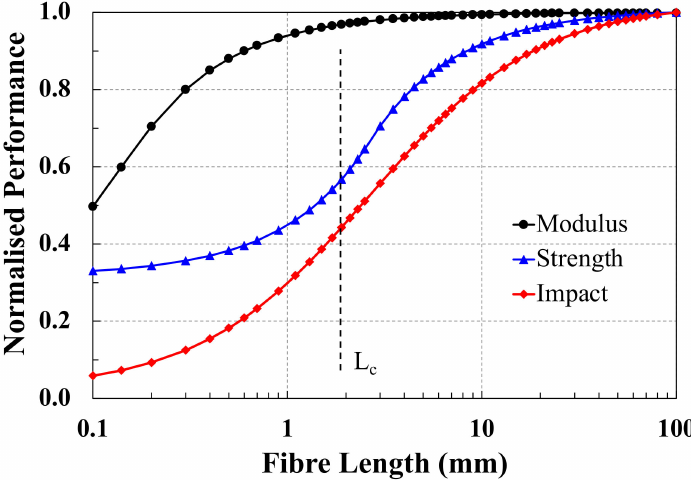
Figure 3. Prediction of normalised performance of GF-PP composite versus fibre length [4].